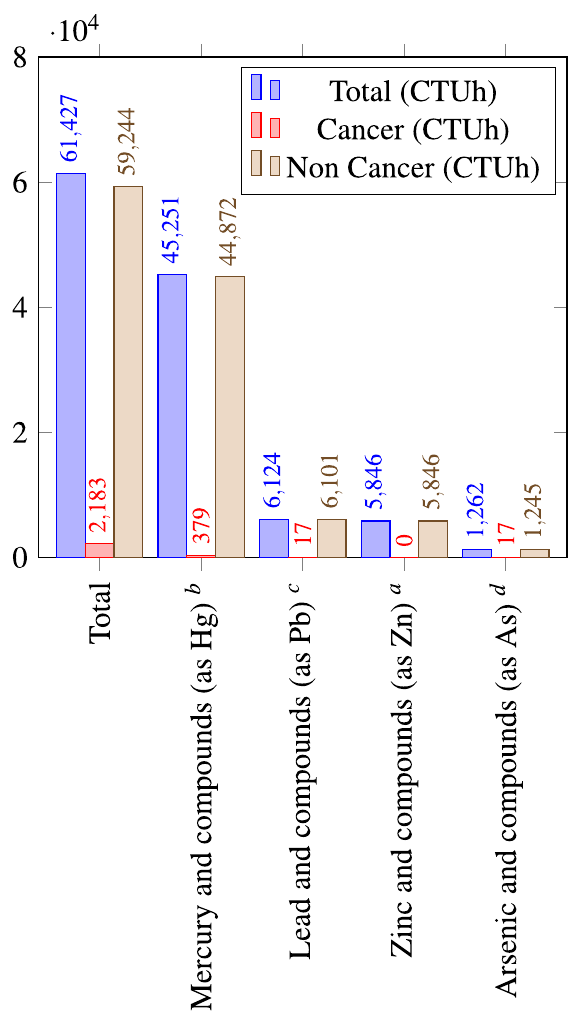
Figure 1. Contribution of substances to cancer, non-cancer and total human toxicity (CTUh), emitted from point sources reported under E-PRTR to air and water (2017), characterized with USEtox 2.12. Only the total contribution and the four substances with largest contributions are